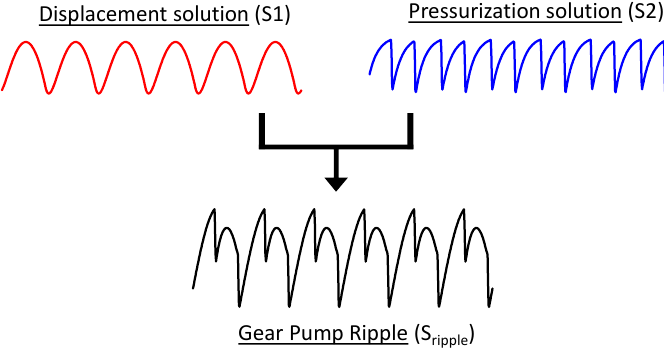
Figure 9. Solution of the decoupled solution and their superposition.